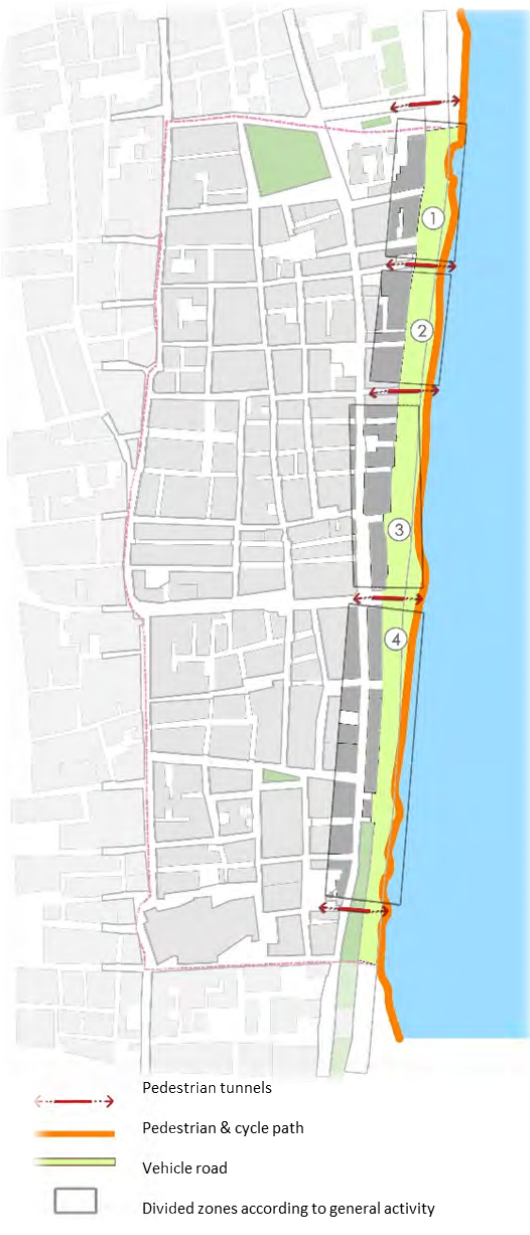
Figure 22. (Rasheed waterfront